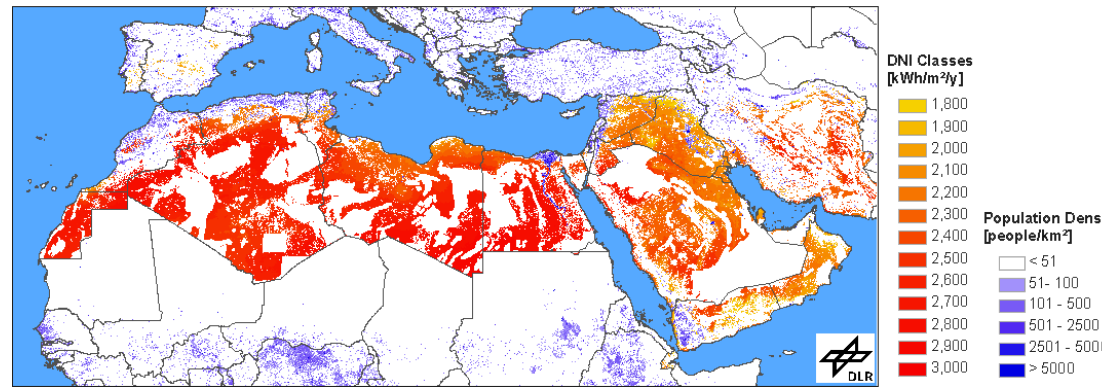
Figure 8. Concentrating solar power potential in the MENA region; source: ESTELLA (http://www.estelasolar.org/ste-soon-a-major-power-source-in-sunbelt-countries/how-ste-can-bring- benefits-to-mena-region/).